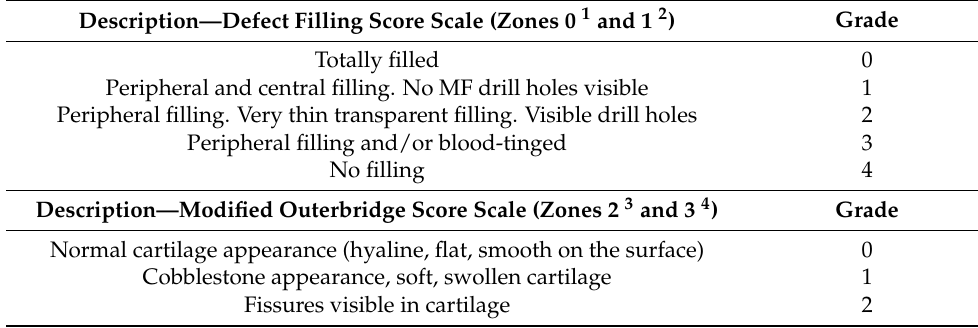
Table A1. Macroscopic scoring table for evaluation of cartilage state and repair in four zones (i.e., Zone 0 to Zone